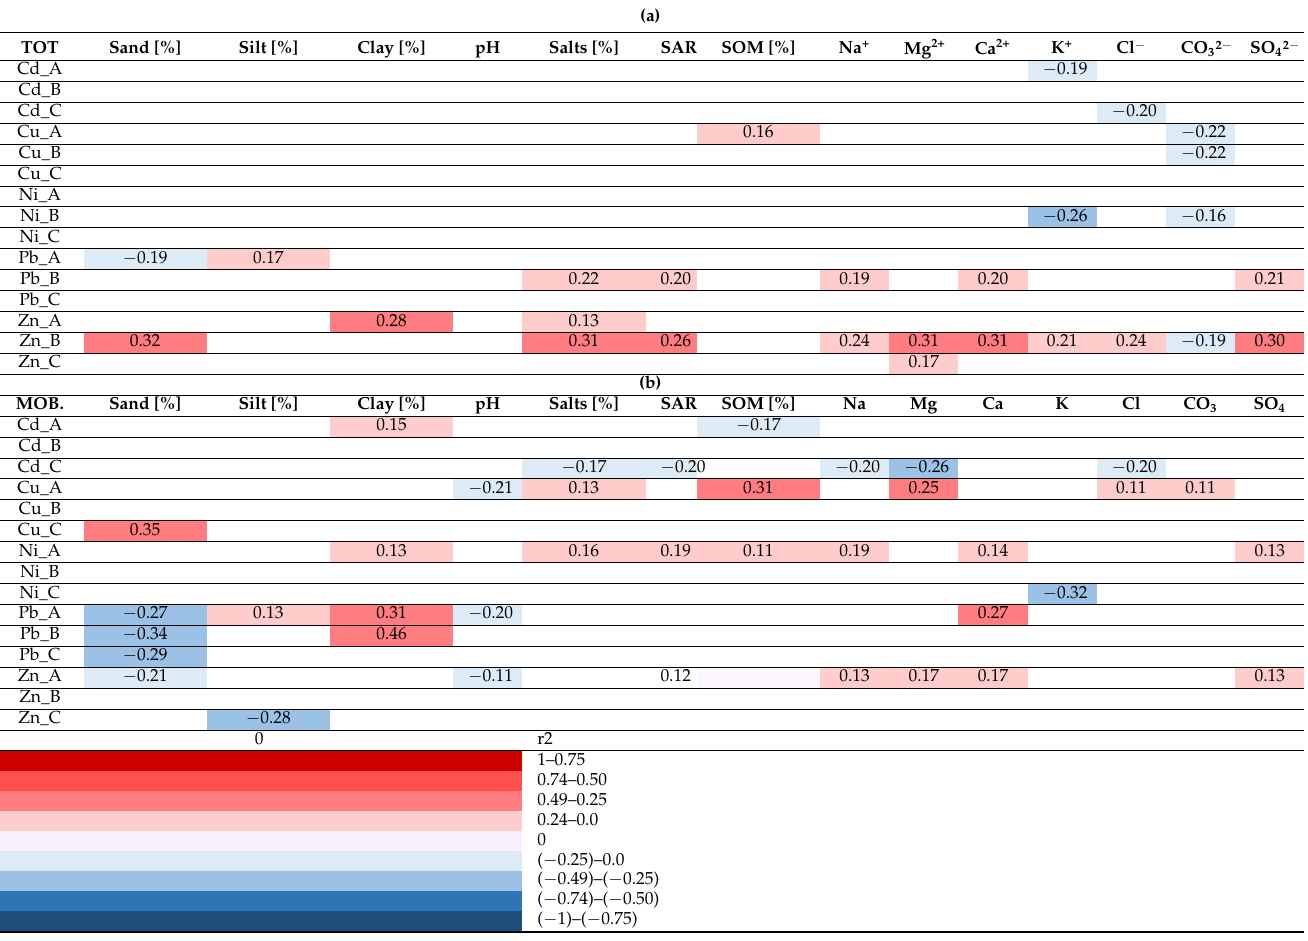
Table 3. Correlations between physicochemical soil properties, including soil salinity and content of total ( a ) and mobile forms ( b ) of heavy metals.